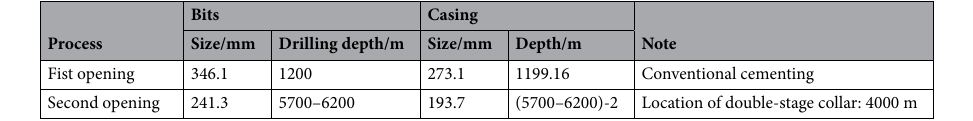
Table 9. Well structure parameters of well